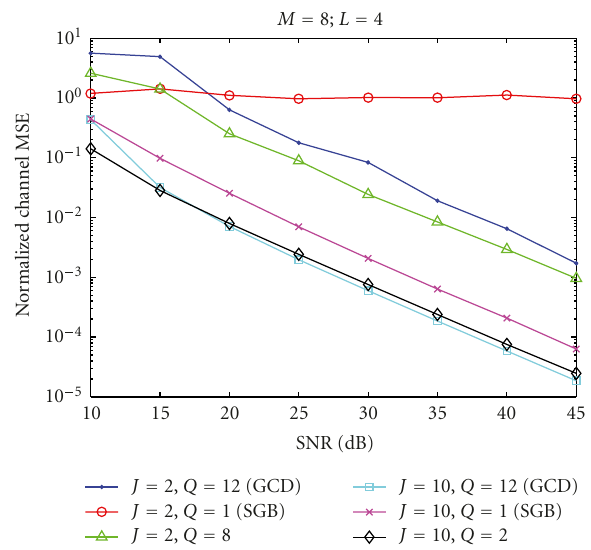
Figure 5: Normalized least squared channel error estimation.